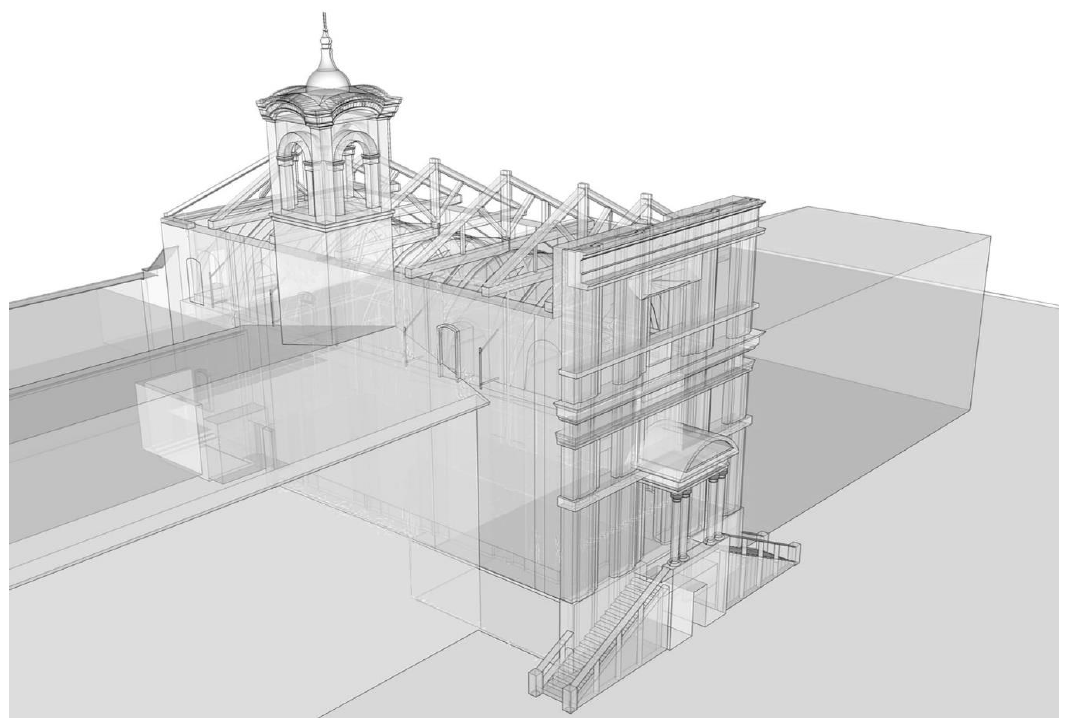
Figure 6. Global digital geometric model of St. Marta church for visualization and documentation.